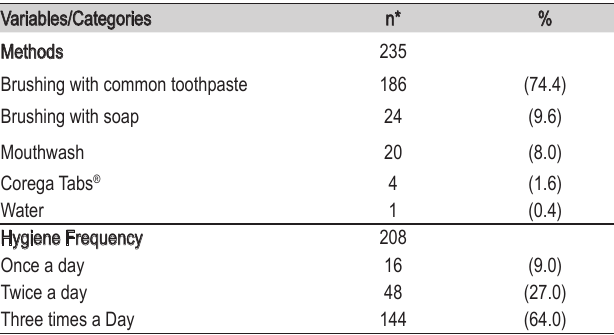
Table 1 - Methods and frequency of hygiene recommended for